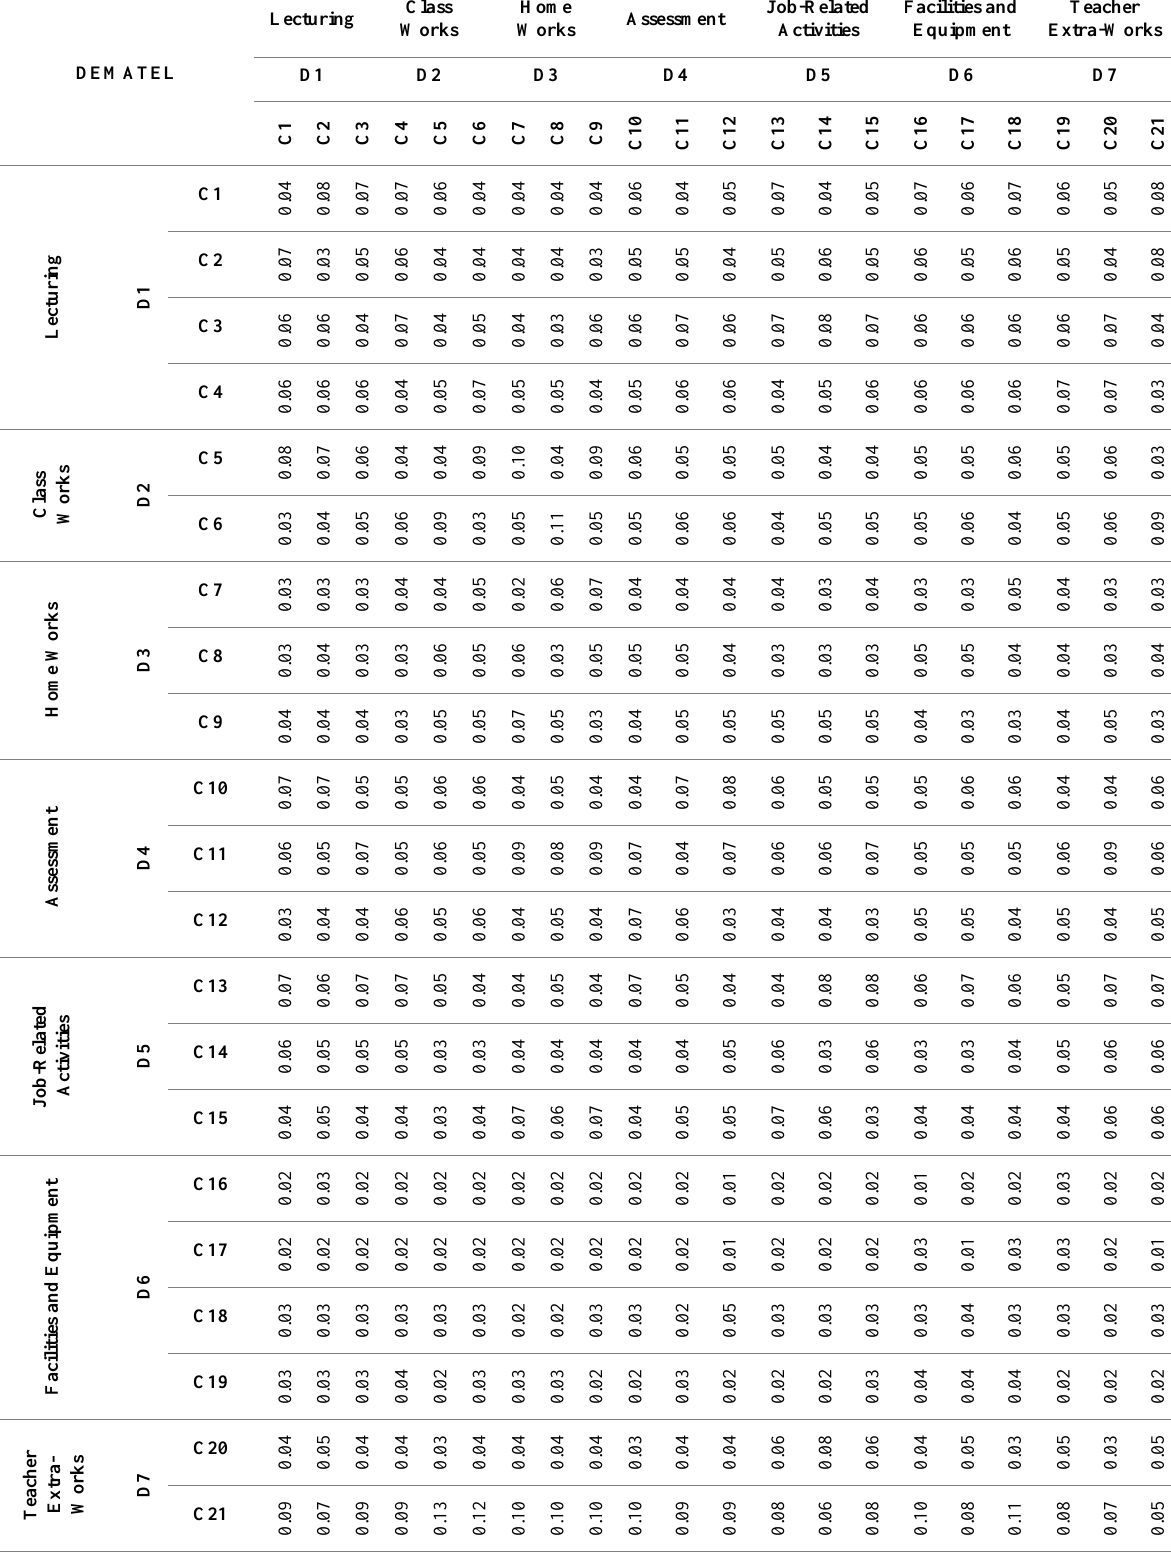
Table 13. Weighted